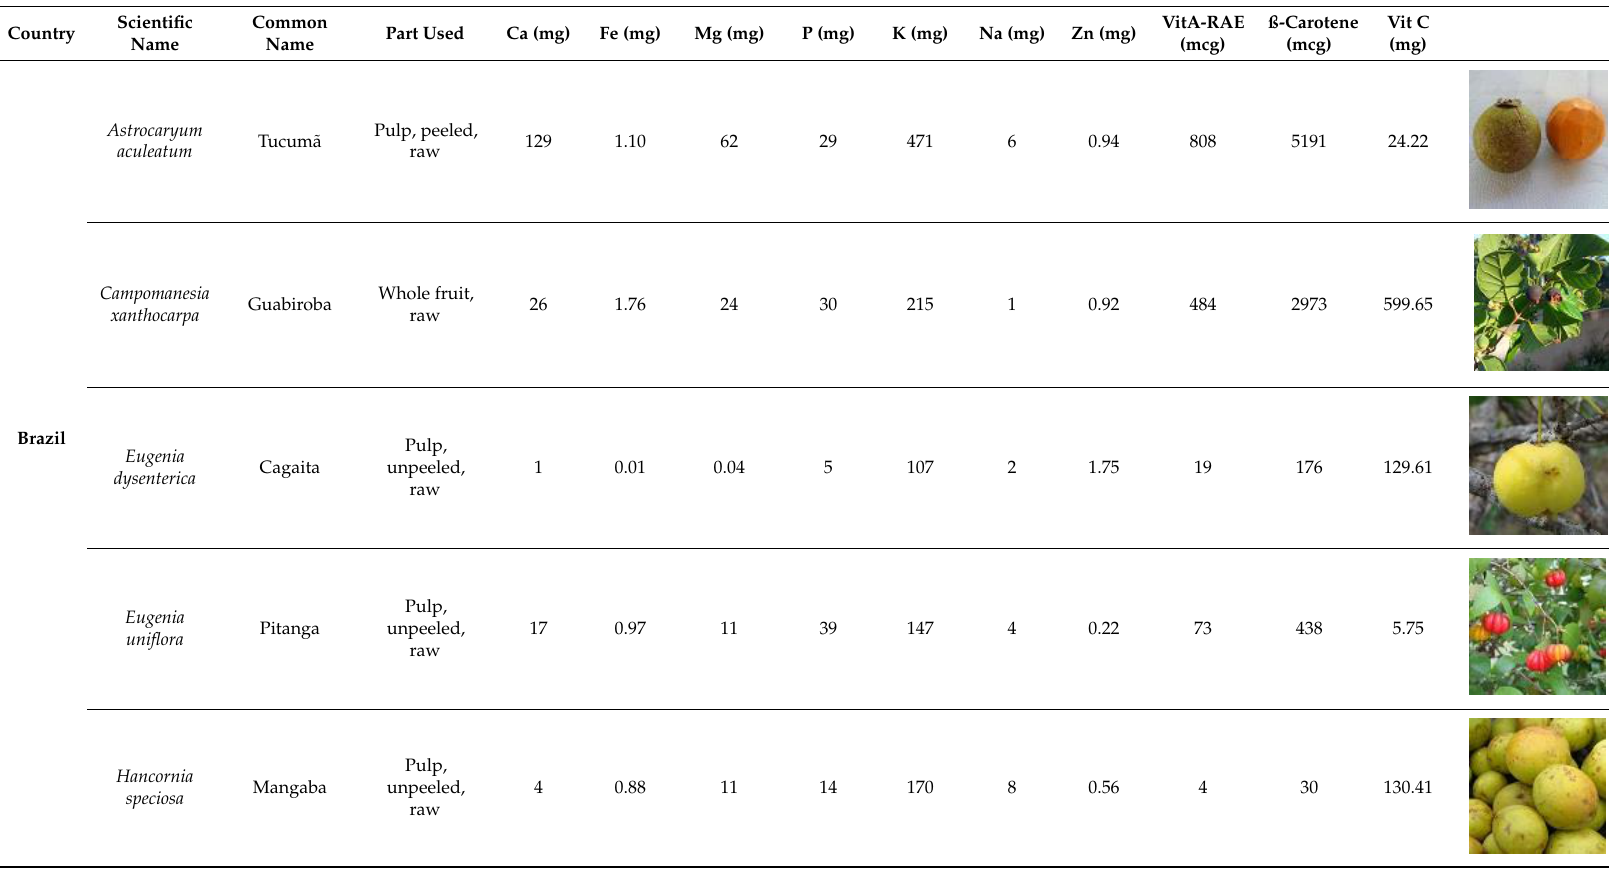
Table 3. The table summarizes the micronutrient content of select underutilized fruits, vegetables and cereals obtained via food composition analyses in Brazil, Kenya and Sri Lanka. Values are expressed per 100g of raw parts used. Source: Biodiversity for Food and Nutrition (BFN) Species Database [63].